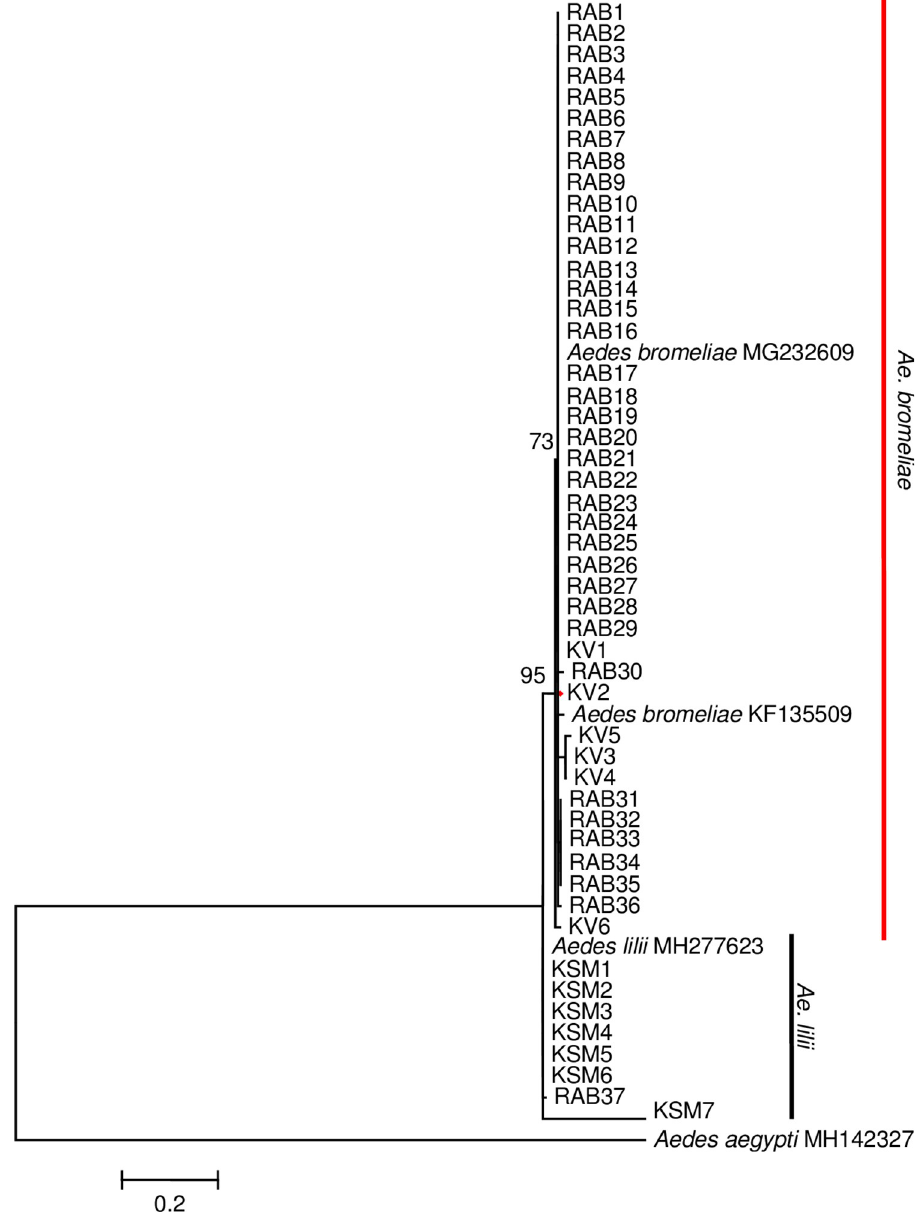
Fig 2. Maximum-likelihood tree derived from selected parous Ae . simpsoni ITS2 sequences using a JC model (216–313 nt). Bootstrap values are shown above relevant nodes. Sequence of Ae . aegypti indicated as outgroup. The scale-bar indicates the number of substitutions per site. Taxon abbreviations represent sampling sites with numbers corresponding to specific sequence samples: RAB, Rabai; KV, Kerio Valley; KSM, Kisumu. Sequences have